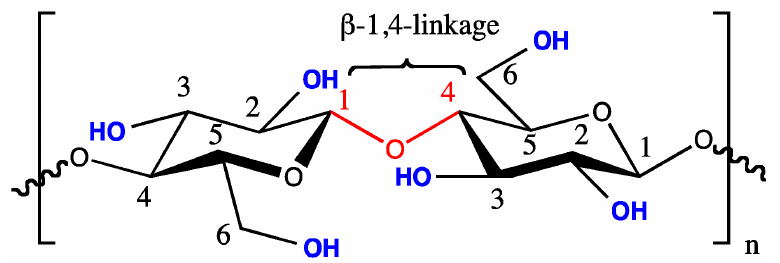
Figure 1. Chemical representation of a single cellulose chain repeat unit depicting two glucose units with a β -1,4-glycosidic linkage [22].